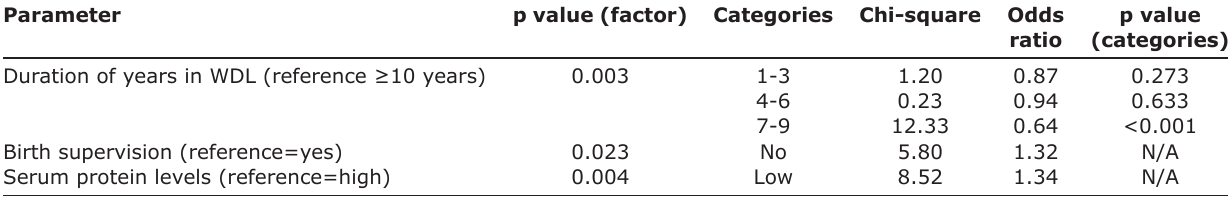
Table-4: Multivariable logistic regression results of factors associated with diarrhea incidence in 110 calves reared in 109 smallholder dairy farms in Mukurwe-ini Sub-County, Kenya.